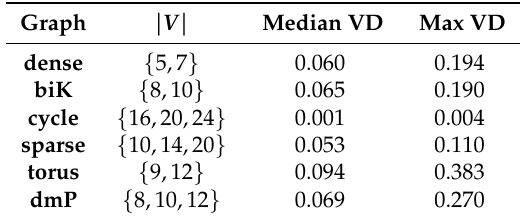
Table 1. Variation distance (VD) for different graph topologies. Median and maximum VD computed over five runs for each network. Since dmP graphs are random, results for dmP were further computed V over five different graphs for each size | |